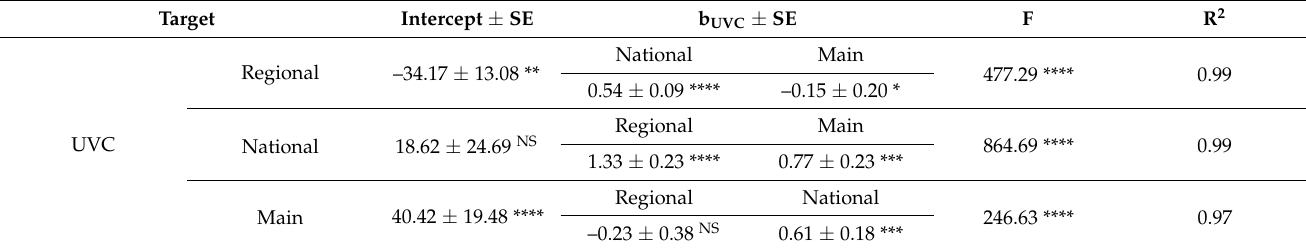
Table 1. Hypotheses that there are no relationships between UVC and UVC hotspot patterns on different categories of roads declined with * p < 0.10, ** p < 0.05, *** p < 0.01, **** p < 0.001. NS: not significant. Response variables are UVCs and UVC hotspots on regional, national, and main roads; b UVC show the degree of change in the response variable for every 1-unit of change in the predictor